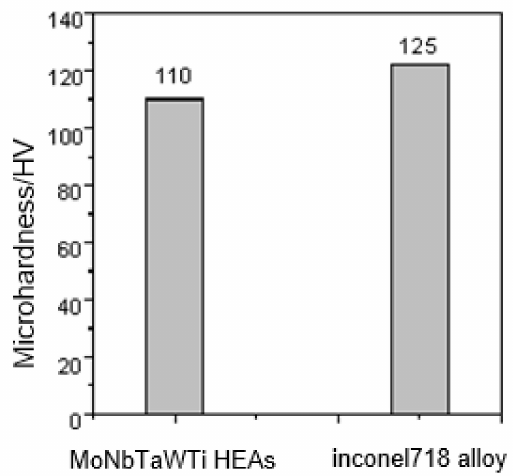
Figure 6. Microhardness of MoNbTaWTi Arc Surfacing layer and Inconel718 alloy at 1000 ◦ C.